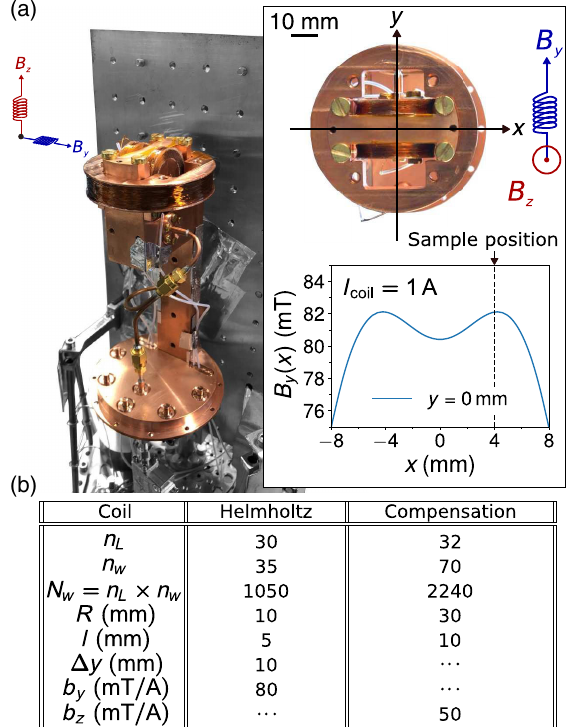
FIG. 6. Photograph of the cryogenic setup used for the magnetic field measurements in Fig. 5. The copper waveguide sample holder equipped with the 2D vector magnet (highlighted in color) is mounted at the dilution stage of a tabletop Sionludi dilution refrigerator [57] (gray scale), with a base temperature ≈ 20 – 30 mK. The flat copper cylinder visible in the lower T base part of the image is the lid of the outer shield (not shown), which consists of successive copper (Cu) and aluminum (Al) cylinders, similar to Ref. [58]. The Cu shield was used in all measurements presented in Fig. 5, while the Al shield was only used during the “ shielded ” cooldown. The inset shows the top view of the copper waveguide sample holder including the 2D vector magnet (top) and the numerically calculated Helmholtz field (bottom) B for a y 1 A as a function of lateral position x . The bias current I coil ¼ magnetic field of the two Helmholtz coils is aligned within machining precision with the in-plane direction y of the thin films. The B coil is the compensation coil we use to align in situ z the in-plane field. (b) Table summarizing the geometric parameters for the coils of the 2D vector magnet: number of winding layers n , number of windings per layer n , total number of windings L w N , inner coil radius R , coil length l , vertical distance between w Helmholtz coils Δ y , magnetic flux density in y and z direction per 1 A of bias current, b and b , y z